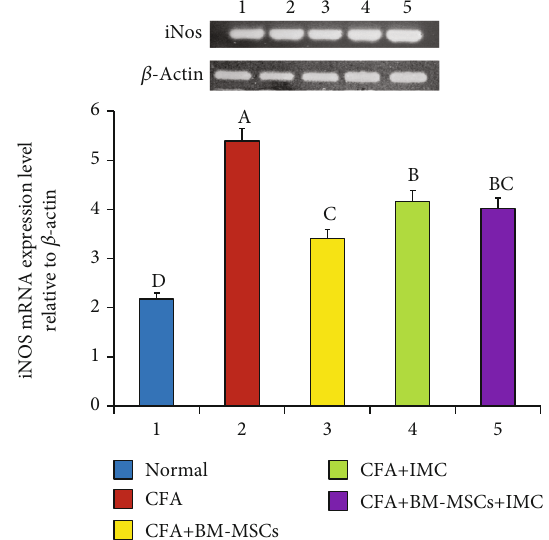
Figure 7: E ff ect of BM-MSCs and/or IMC on the iNOS level mRNA expression relative to β -actin in CFA-induced rats. Means, which have di ff erent symbols, A, B, C, and D, are signi fi cantly di ff erent at p < 0 : 05 .